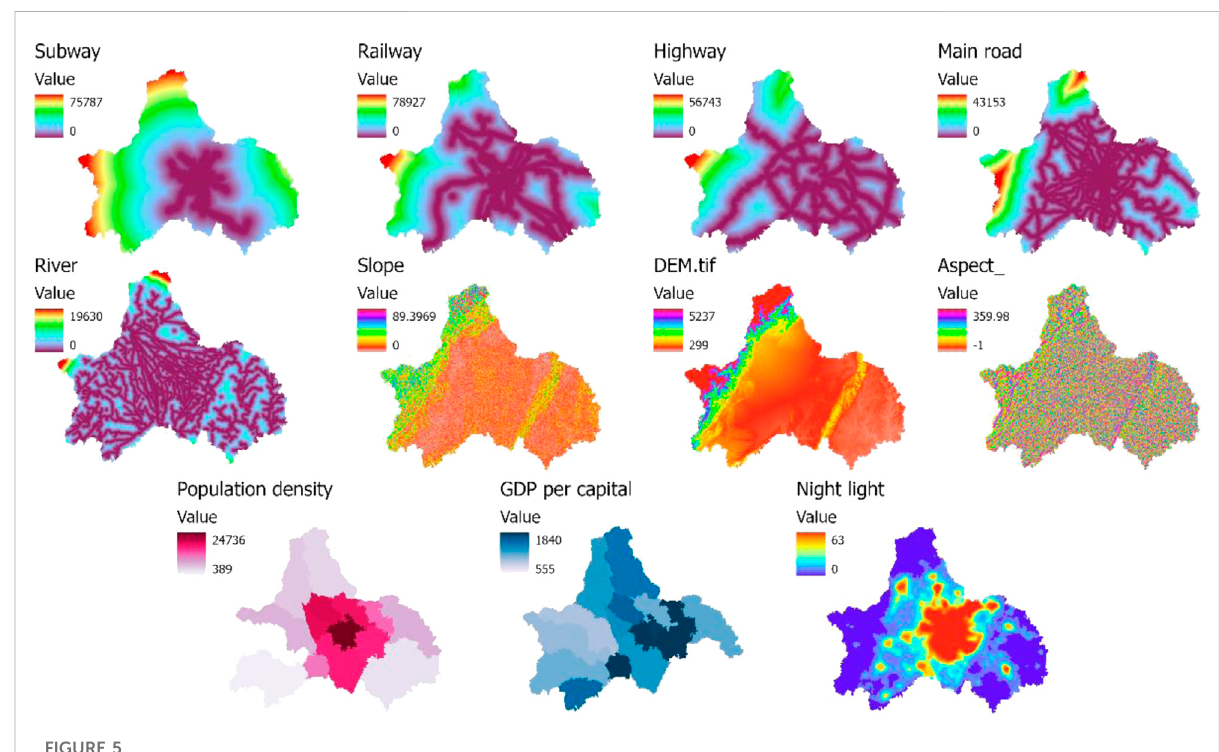
FIGURE 5 Driving factor for ANN-based Probability-of-occurrence